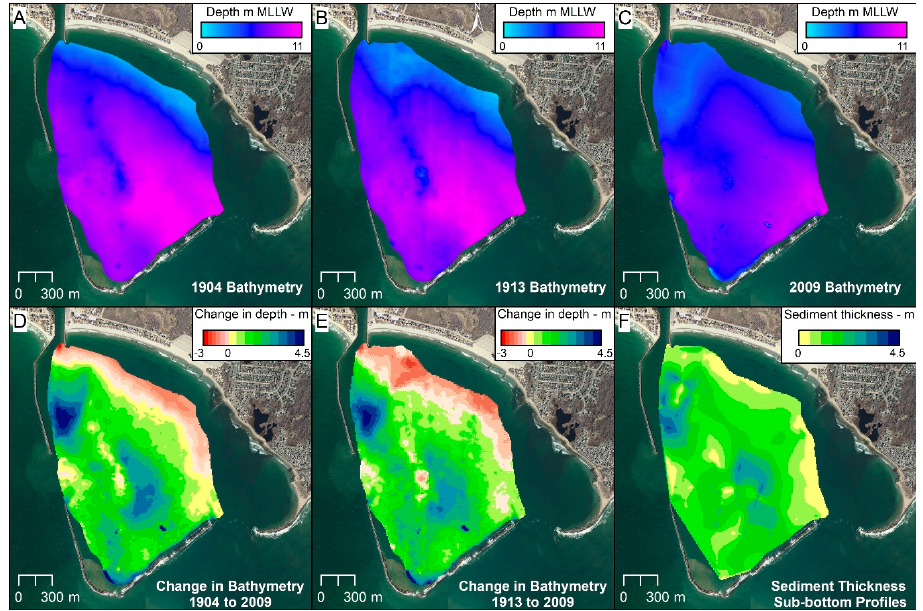
Figure 8. ( A ). Bathymetry in 1904 (m below 2009 mean lower low water (MLLW)) ( B ). Bathymetry in 1913 (m below 2009 MLLW) ( C ). Bathymetry in 2009 (m MLLW). Note that all three panels ( A – C ) are displayed using the same color ramp, and the shoaling is apparent by the decrease in purple (deeper areas) in 2009 and erosion of the upper shoreface shown by the darker blues in the same period ( D ). Di ff erence in elevation between 1904 and 2009 bathymetric surfaces ( E ). Di ff erence in elevation between 1913 and 2009 bathymetric surfaces ( F ). Sediment thickness interpreted from sub-bottom